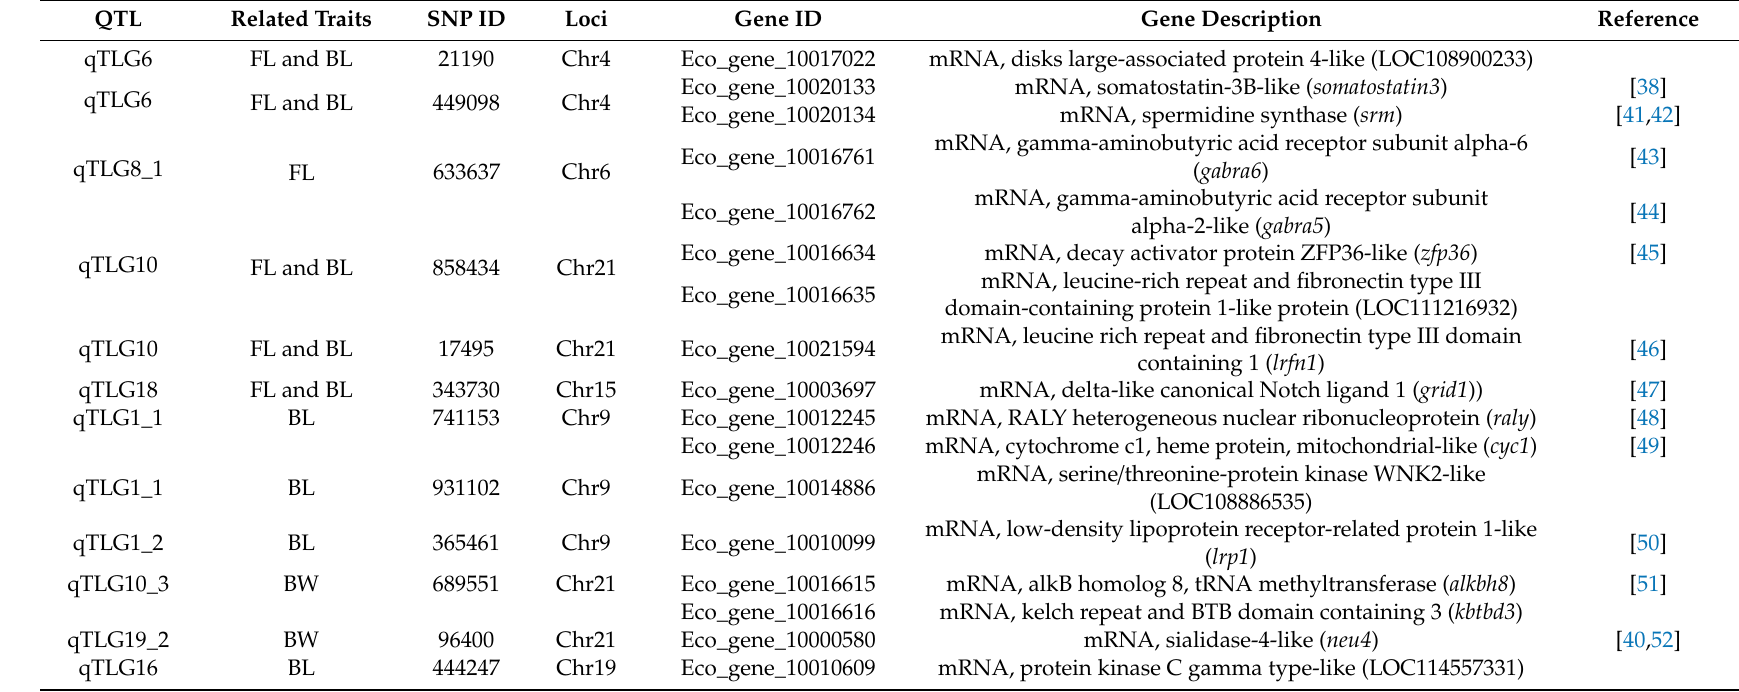
Table 3. Growth-related candidate genes in the red-spotted